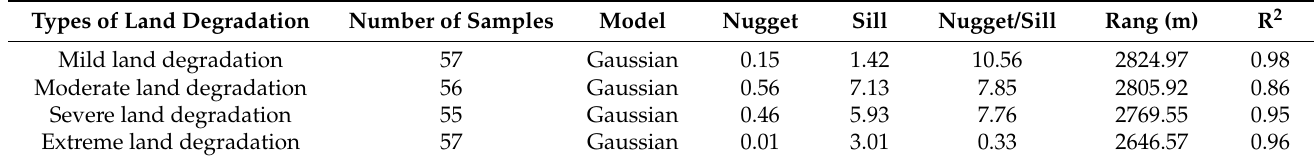
Table 3. Semi-variogram parameters of SOM in soil with different vegetation